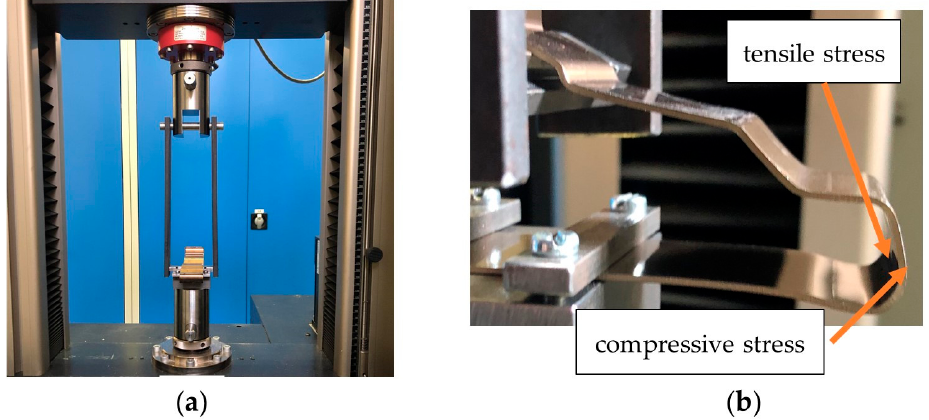
Figure 5. ( a ) Test setup with ZwickRoell Universal testing machine; ( b ) Close − up of fixed clamp during the test procedure in a bent position with acting tensile stress on the inside and acting compressive stress on the outside of the clamp while the tensile force was applied.